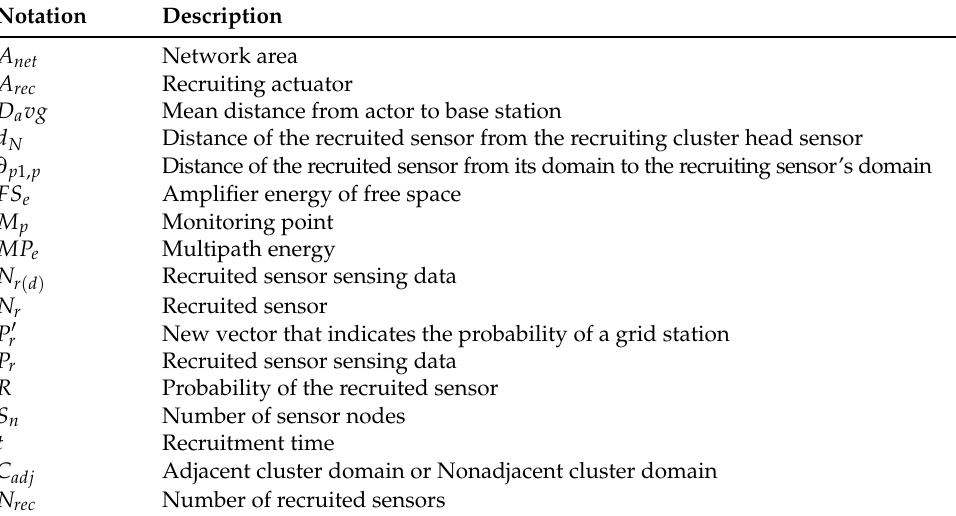
Table 1. Variables used in the recruitment process.